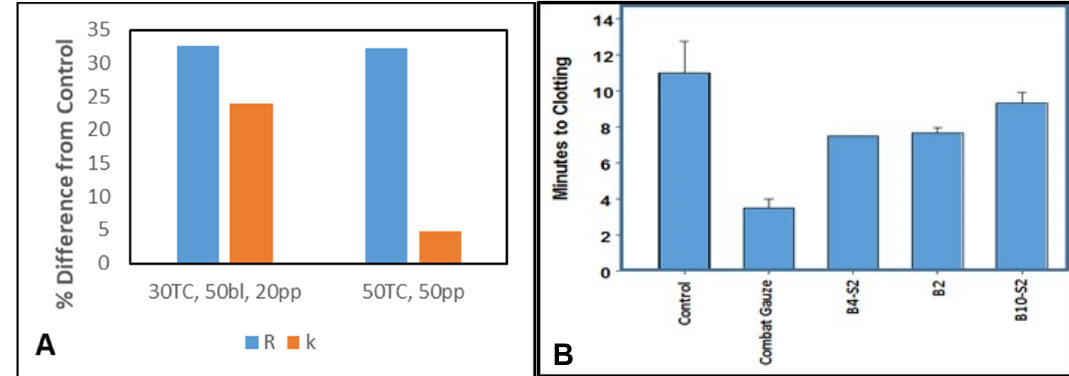
Figure 7. ( A ) Plots of the percent difference in R (time to fibrin formation) and k (time to clot formation), determined with thromboelastography between untreated blood control and fabric treated blood. ( B ) Lee White clotting assay results for (30/50/20, gc/bl/pp, B4-S2 and B2) and (33/33/33, gc/bl/pp, B10-S2), and a positive control containing a procoagulant added to the fabric. A plot of percent differences in R (time to fibrin formation) and k (time to clot formation) for nonwoven samples at a blend ratio of (30/50/20, gc/bl/pp) for three sets of fabrics produced at increasing hydroentanglement waterjet pressures (60, 80, and 100 bar). Standard deviations, n = 3, Statistical analysis done in Sigma Plot with All Pairwise Multiple Comparison Procedures (Holm–Sidak method).